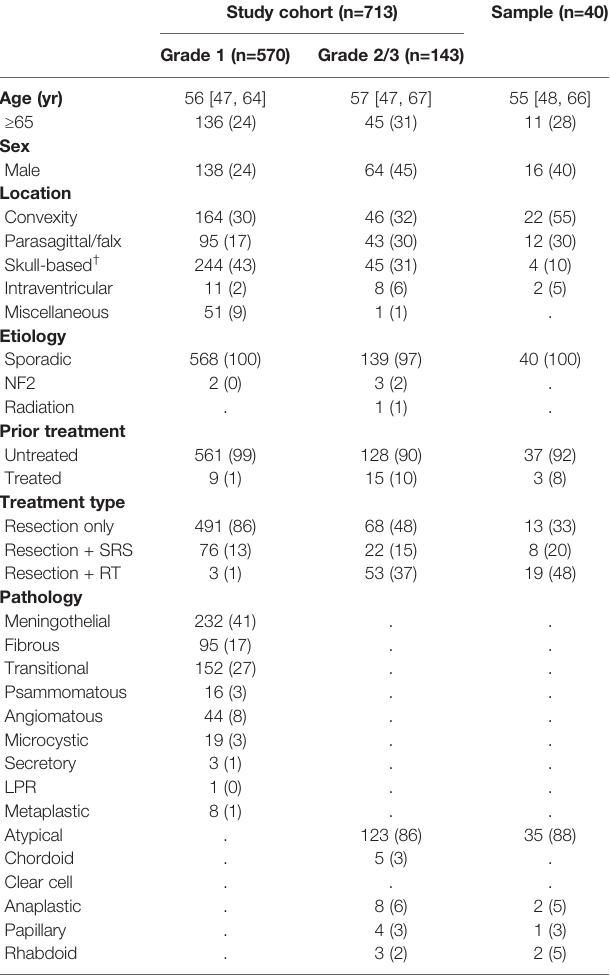
TABLE 1 | Baseline characteristics of the study